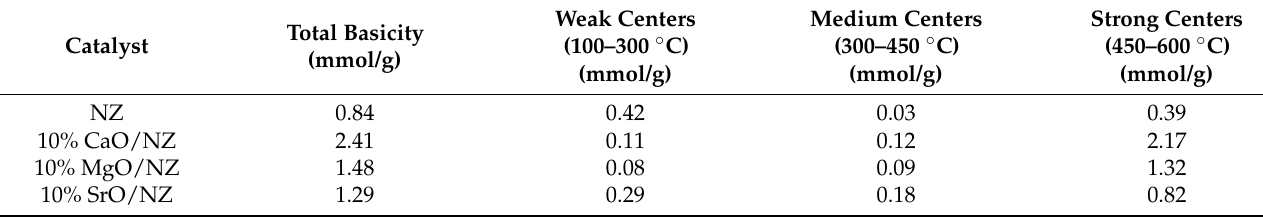
Table 3. The amount of CO 2 adsorbed on the support surface (calcined in an air atmosphere for 4 h at 400 ◦ C), metal oxide calcined catalysts, calculated from the CO 2 -TPD profiles.